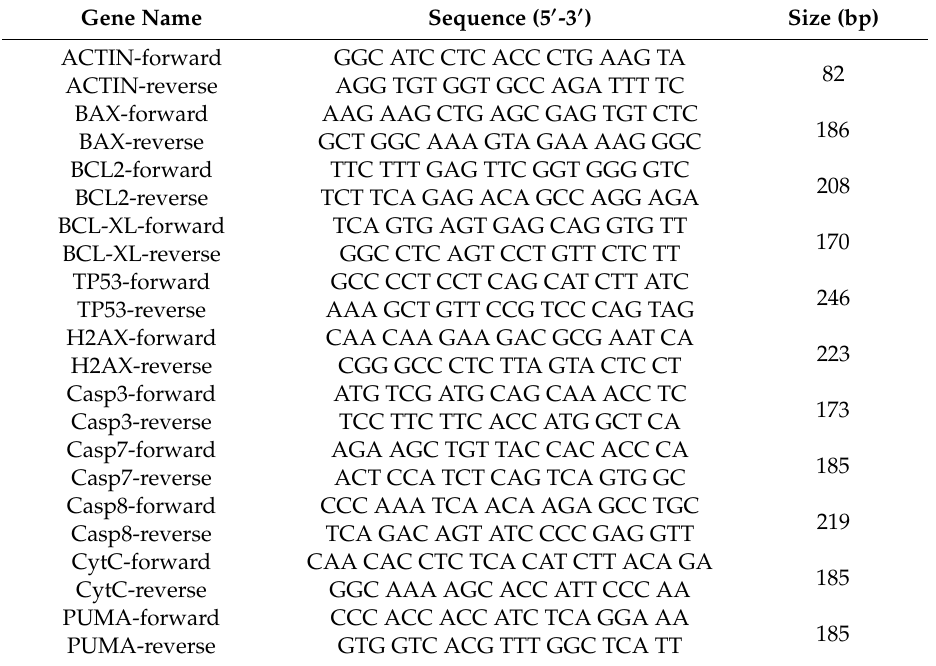
Table 1. List of primer sequences used in this